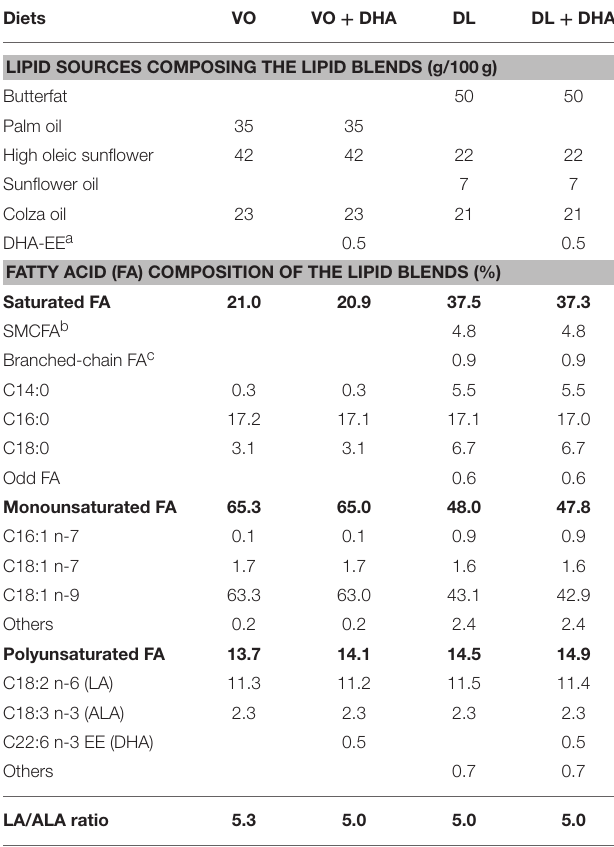
TABLE 1 | Oil mixtures and fatty acid composition of the lipid blends composing the four experimental diets. Diets VO VO + DHA DL DL + DHA LIPID SOURCES COMPOSING THE LIPID BLENDS